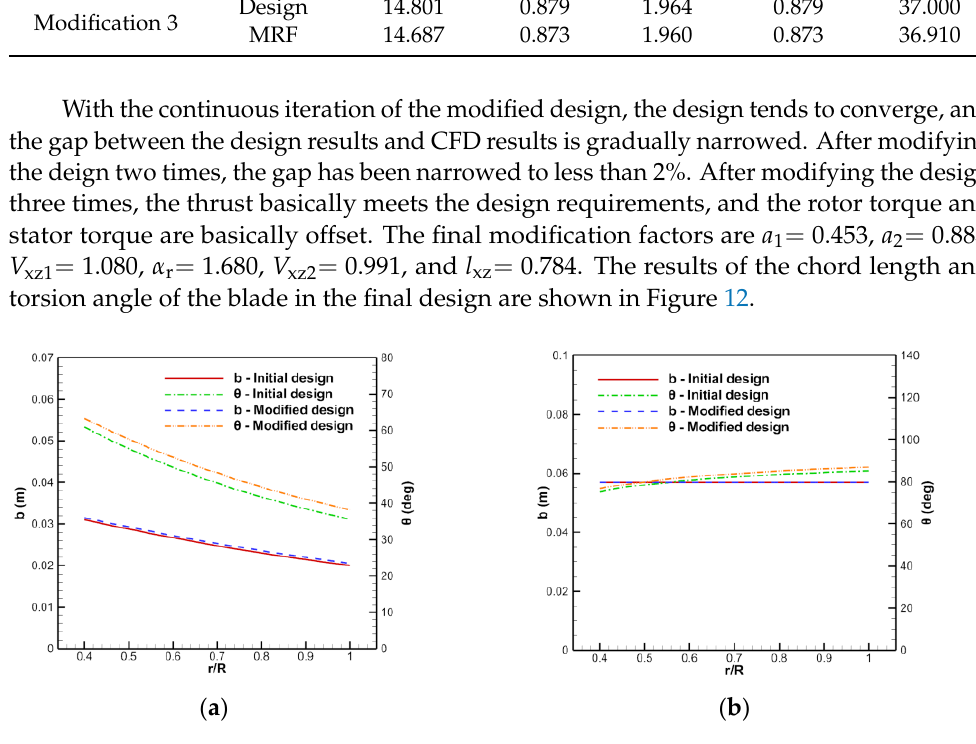
Table 5. Performance comparison of the 150 ducted fan in the incoming flow state.